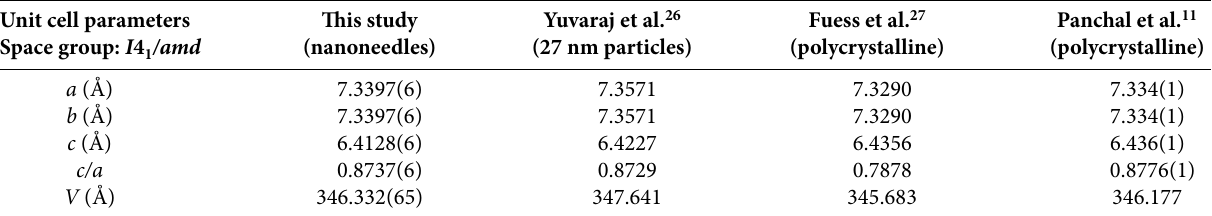
Table 1. The unit cell parameters obtained after Rietveld refinement of the NdVO 4 nanoneedles and a comparison with the literature-reported val- ues. Unit cell